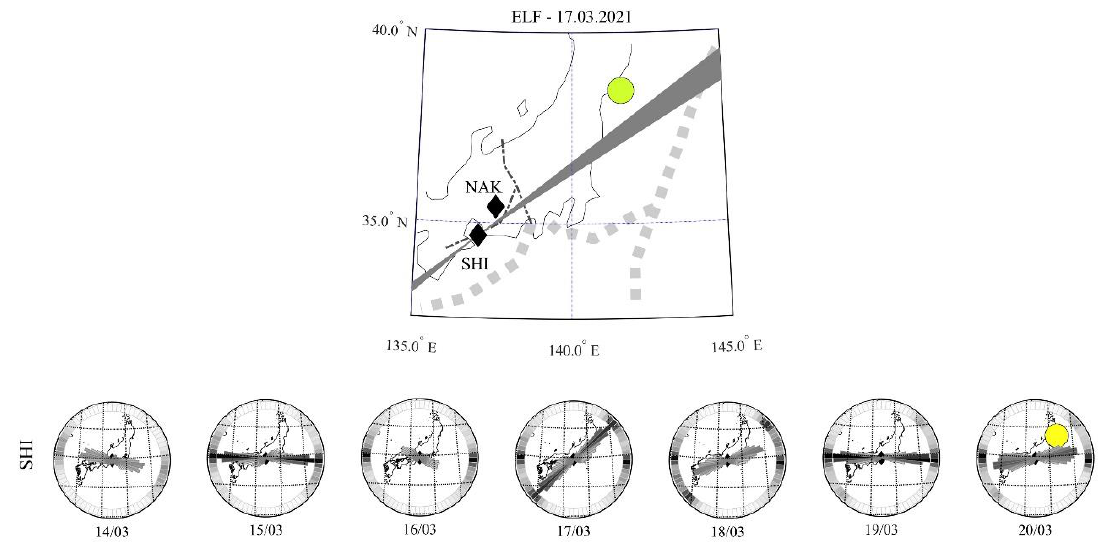
Figure 7. The evolution of the azimuthal distribution of ULF/ELF radiation for the second EQ on 14 – 20 March 2021 observed in SHI. The upper panel shows the position of the main lobe of the azimuthal distribution observed on 17 March.